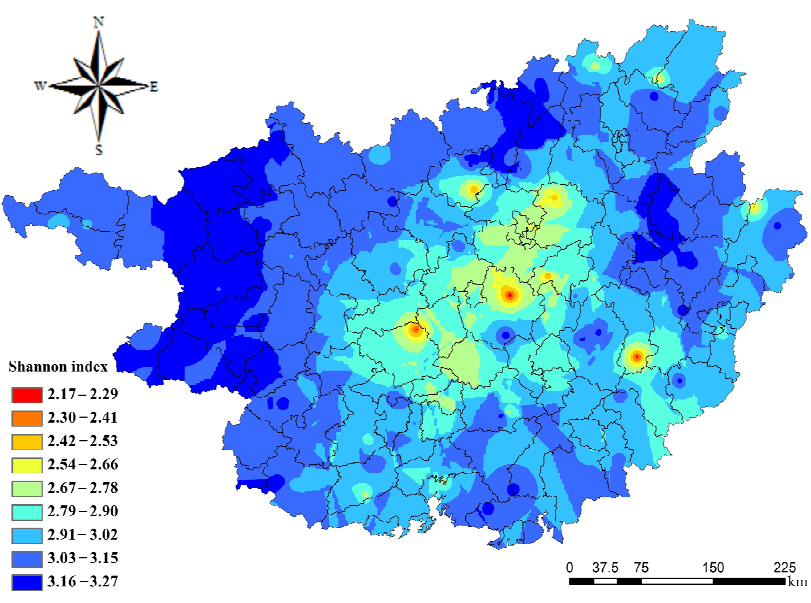
Figure 2. Map of forest soil microbial functional diversity on the scale of the Guangxi territory.